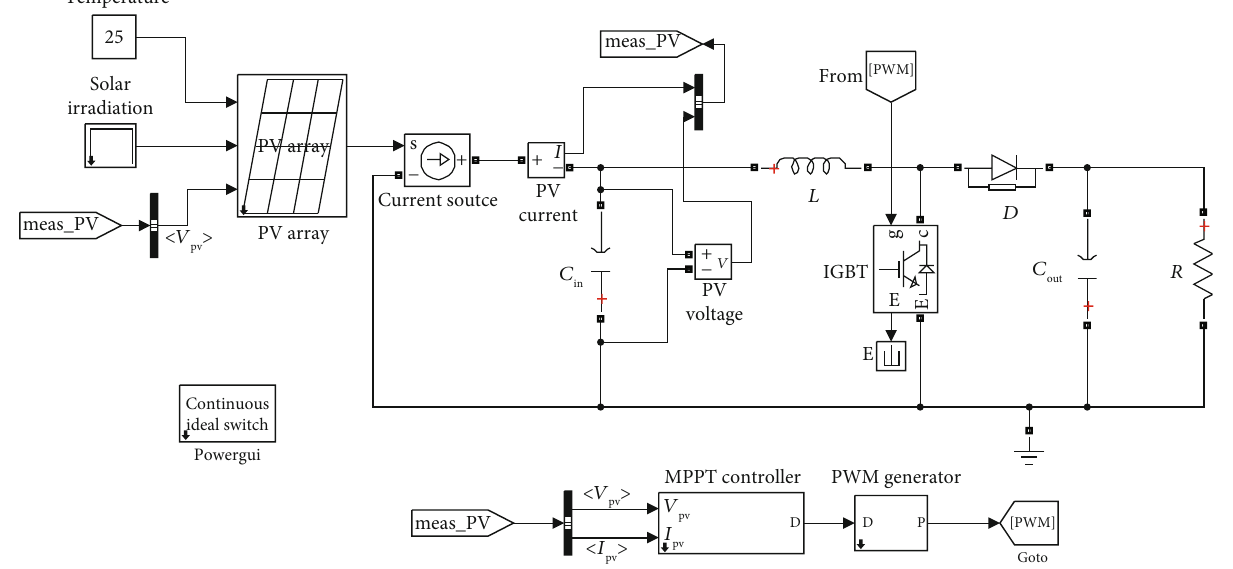
Figure 7: MATLAB simulation model of the MPPT controller and boost